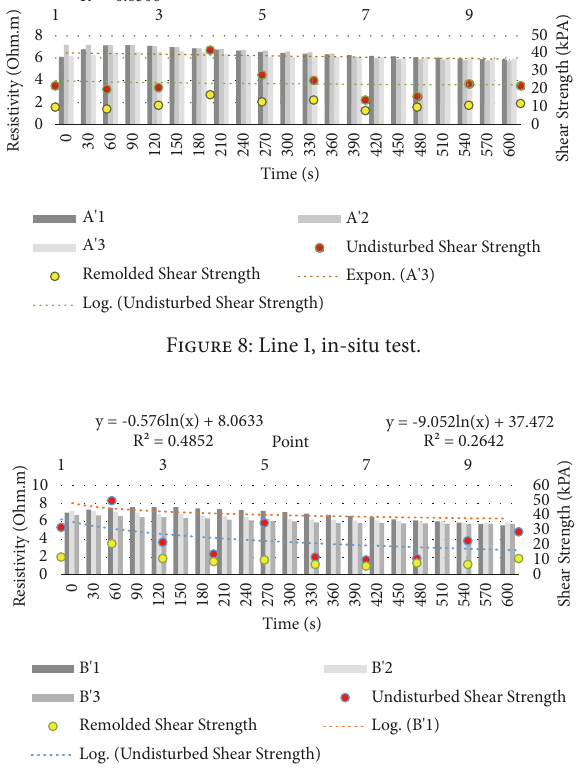
Figure 9: Line 2, in-situ test.